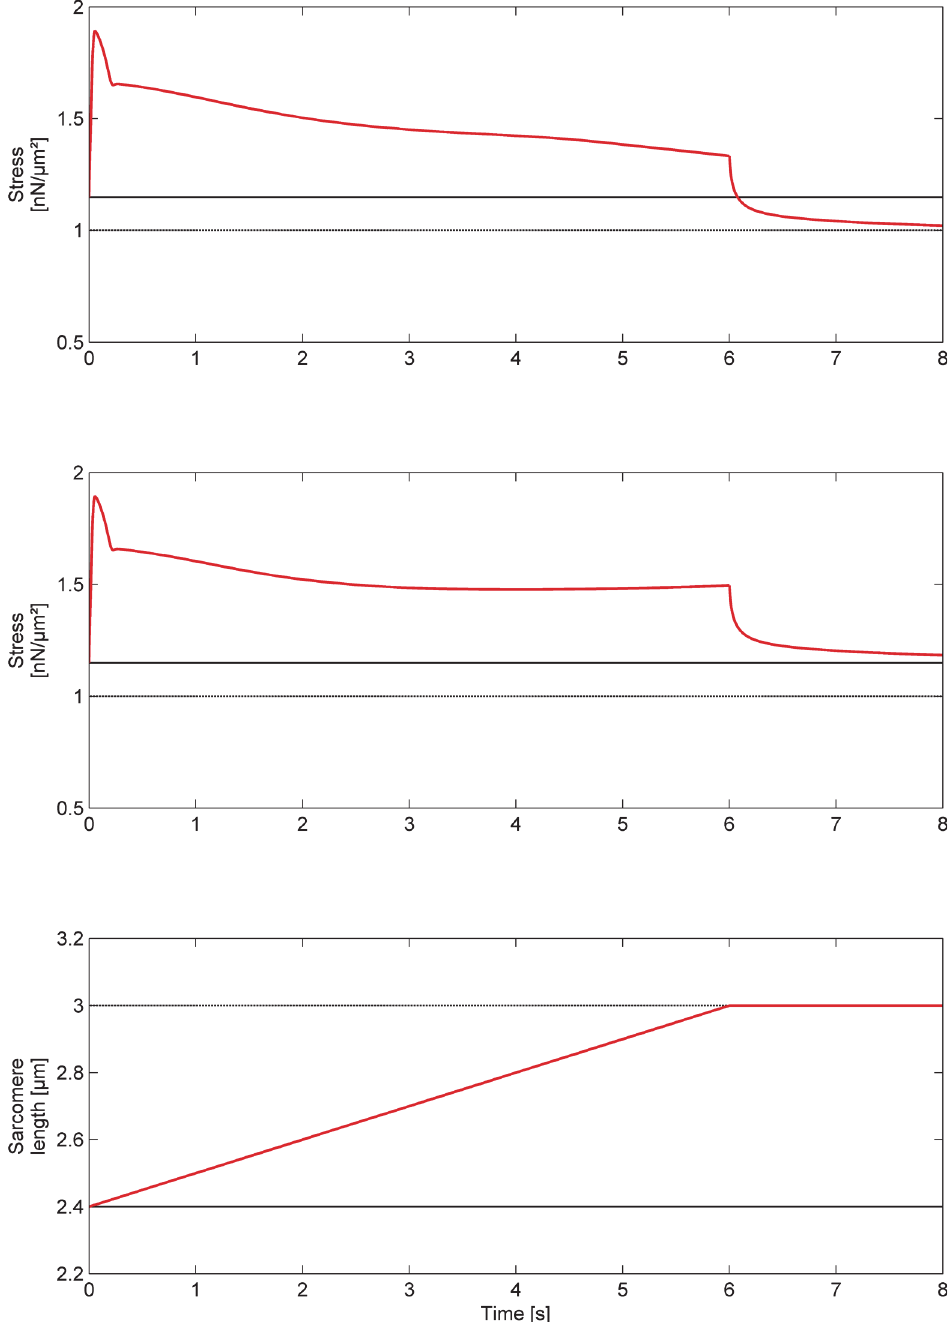
Fig 6. Simulation of an experiment where the sarcomere is activated at a length of 2.4 μ m and stretched to 3 μ m (see also Fig. 5). The resulting force is normalized to the corresponding isometric force at 3 μ m. Forces for the regular cross-bridge model (top panel) and the three filament model (second panel) are calculated for a stretching velocity of 100nm/s/Sarcomere length. The corresponding sarcomere length is shown in the third panel. In contrast to the regular cross-bridge model the three filament model predicts force enhancement in a single (half) sarcomere.